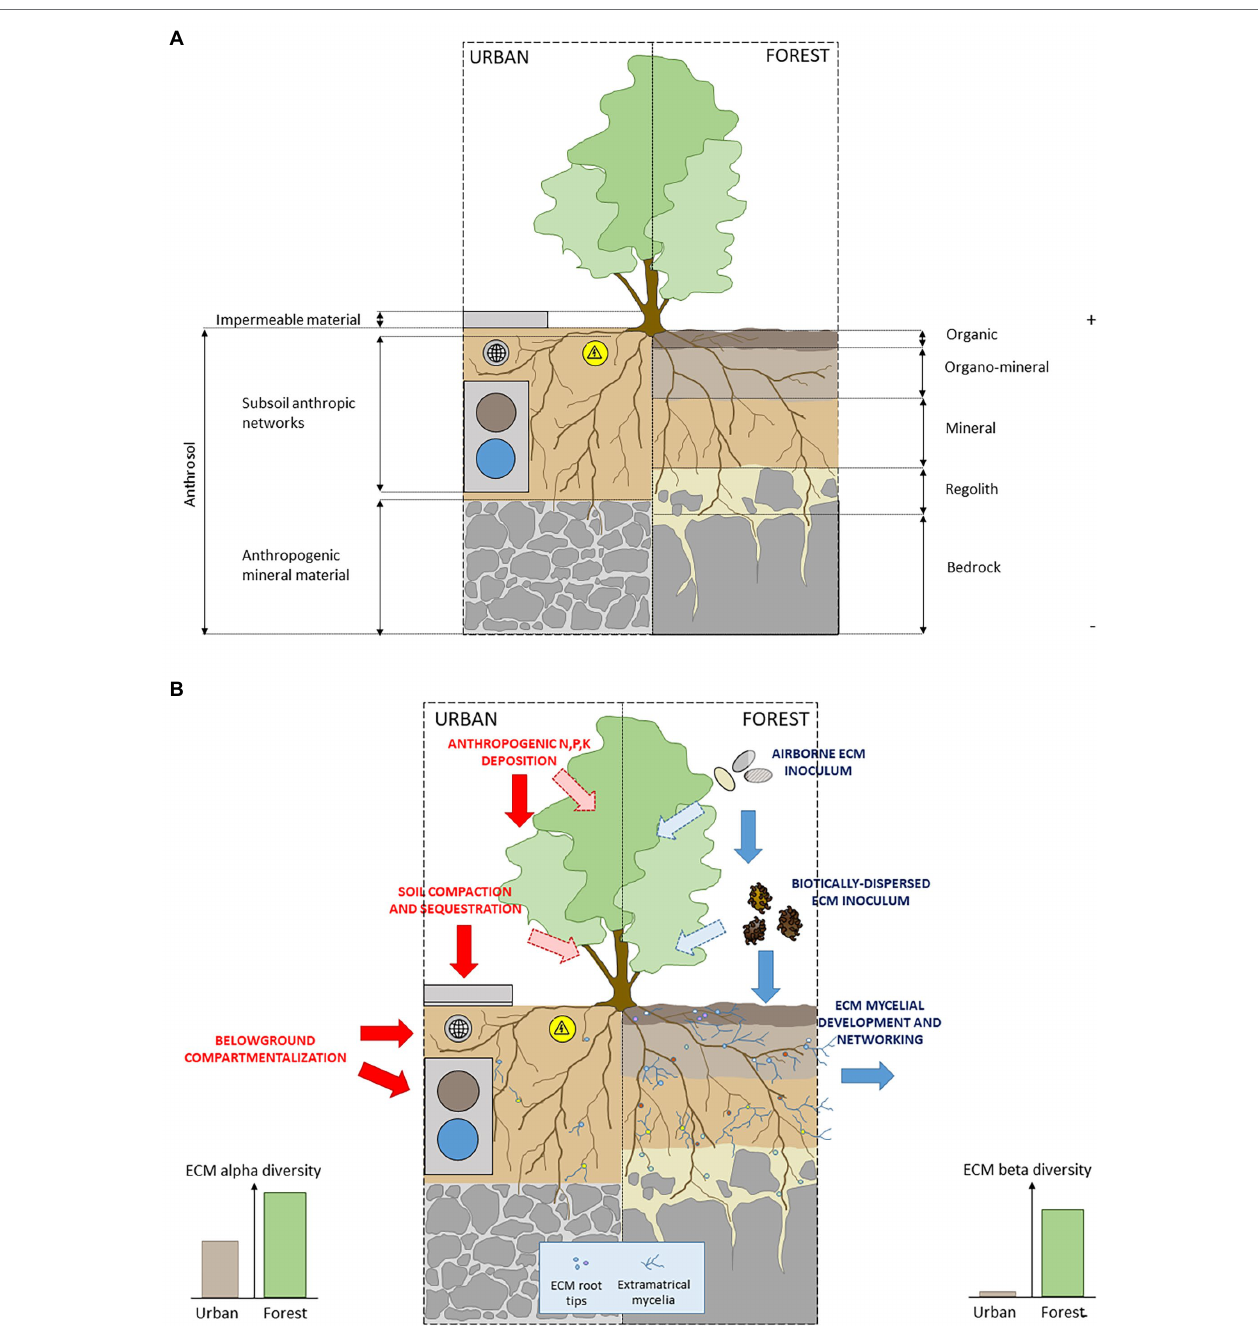
FIGURE 3 | (A) Schematic representation of pedogenic conditions for the development of ectomycorrhizal plants in urban and forest soil conditions and (B) schematic representation of ECM network-based mechanisms and anthropic filters in urban and forest soils